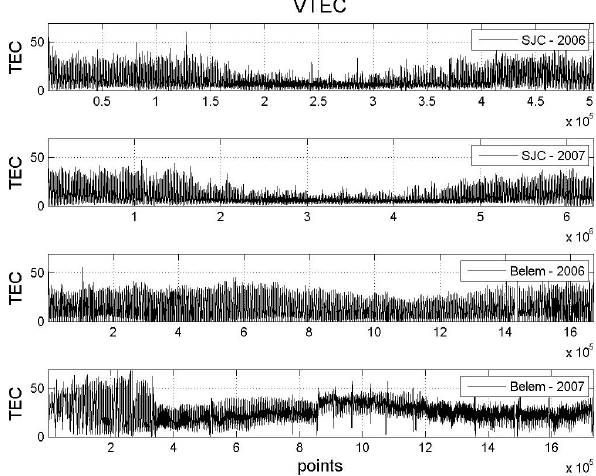
Figure 2: The four time series shown in legend. 440 Fig. 2. The four time series shown in